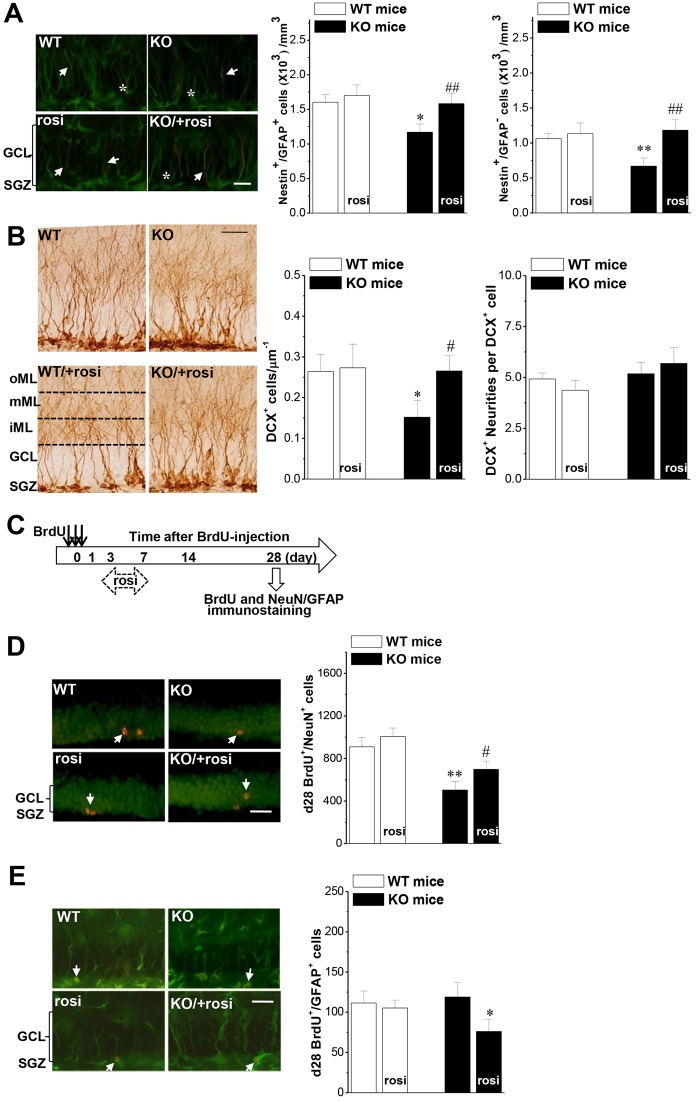
By reducing PPARγ, seipin deficiency suppresses neuronal differentiation of progenitor cells in the DG. (A) Influence of seipin deficiency on the differentiation of neuronal stem cells. Bar graphs show the density of nestin+/GFAP+ cells or nestin+/GFAP− cells in seipin-nKO mice and WT mice treated with rosi or vehicle for 3 days before the last injection of BrdU. Representative images of nestin/GFAP immunostaining are shown. GCL indicates the granule cell layer. SGZ indicates the subgranular zone. White arrows indicate nestin+/GFAP+ cells; white asterisks indicate nestin+/GFAP− cells. Scale bar: 25 μm. *P<0.05 vs WT mice; **P<0.01 vs WT mice; ##P<0.01 vs seipin-nKO mice. (B) Bar graph shows mean number of DCX+ cells and density of DCX+ fibers in seipin-nKO mice and WT mice treated with rosi or vehicle for 3 days before the last injection of BrdU. Representative images of DCX immunostaining are shown. The molecular layer (ML) of the DG was divided into three subregions: the inner (iML), middle (mML) and outer (oML) ML. Scale bar: 50 μm. *P<0.05 vs WT mice; #P<0.05 vs seipin-nKO mice. (C) Time chart of experimental procedure. (D,E) Influence of seipin deficiency on neuronal differentiation of progenitor cells. Bar graph shows mean number of d28 (28 days after last BrdU injection) BrdU+/NeuN+ cells and d28 BrdU+/GFAP+ cells in seipin-nKO mice and WT mice. Rosi was administered on d3-d7 after the last injection of BrdU. Representative images of BrdU/NeuN and BrdU/GFAP immunostainings are shown. White arrows indicate BrdU+/NeuN+ cells and BrdU+/GFAP+ cells. Scale bars: 50 μm. (D) **P<0.01 vs WT mice; #P<0.05 vs seipin-nKO mice; (E) *P<0.05 vs seipin-nKO mice.